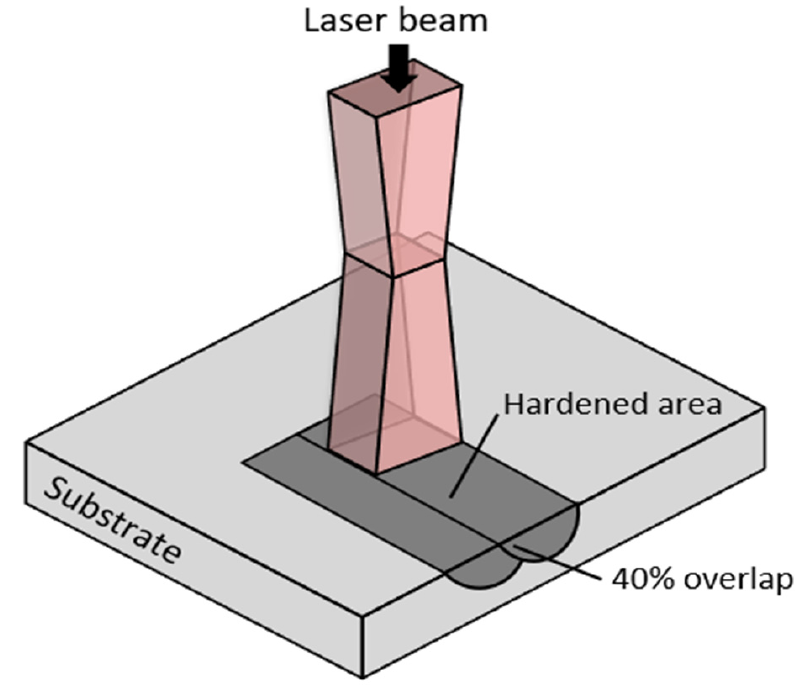
Figure 2. Schematic of the laser surface hardening process with 40% overlapped scanning.